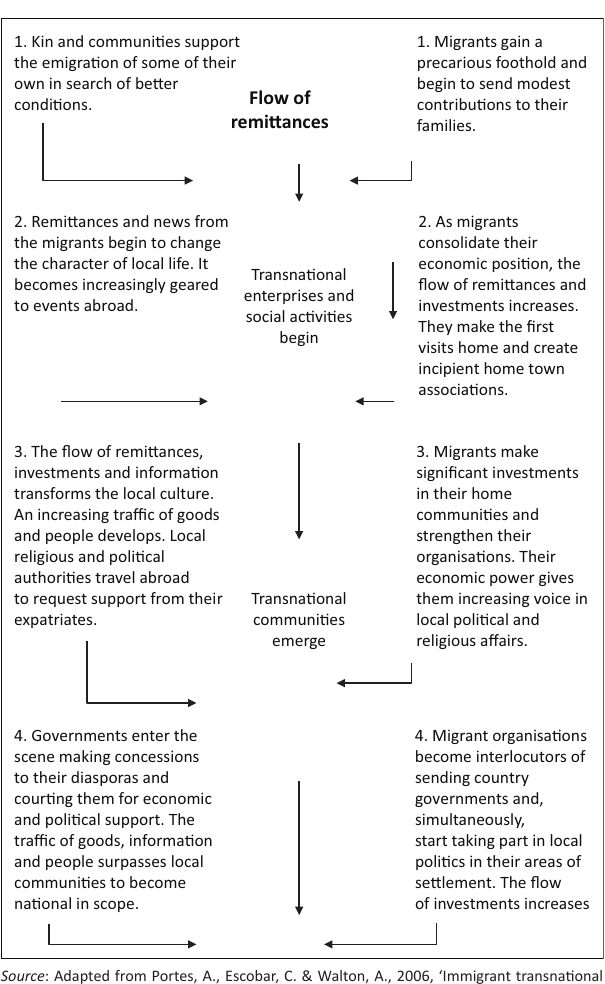
FIGURE 1: The process of immigrant